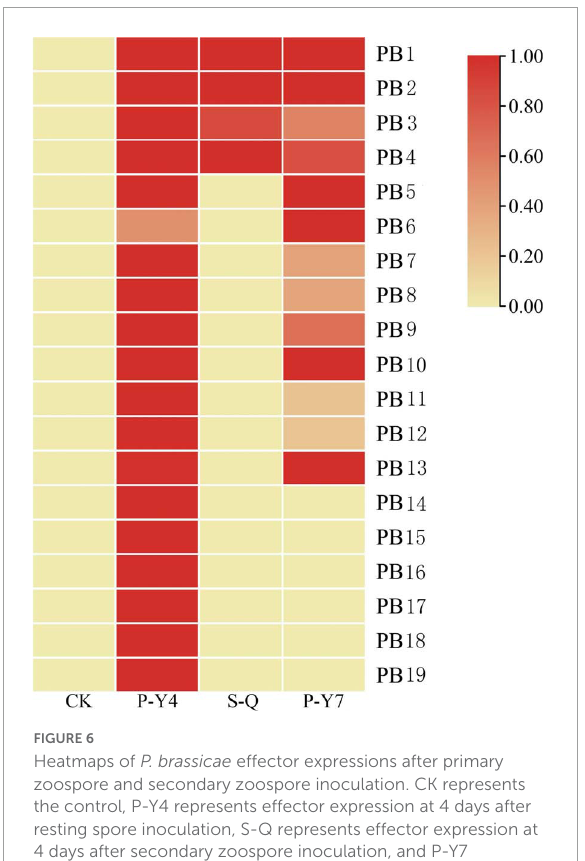
FIGURE6 Heatmaps of P. brassicae effector expressions after primary zoospore and secondary zoospore inoculation. CK represents the control, P-Y4 represents effector expression at 4 days after resting spore inoculation, S-Q represents effector expression at 4 days after secondary zoospore inoculation, and P-Y7 represents effector expression at 7 days after resting spore